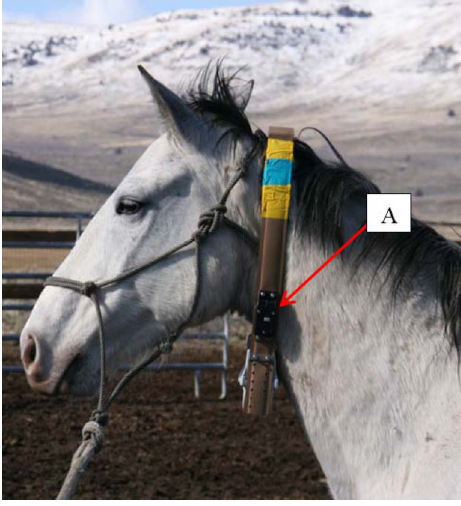
Figure 3. An adult domestic horse fitted with a custom-built VHF/GPS collar. A: location and design of breakaway detachment device constructed of two pieces of parallel rubber tubing.